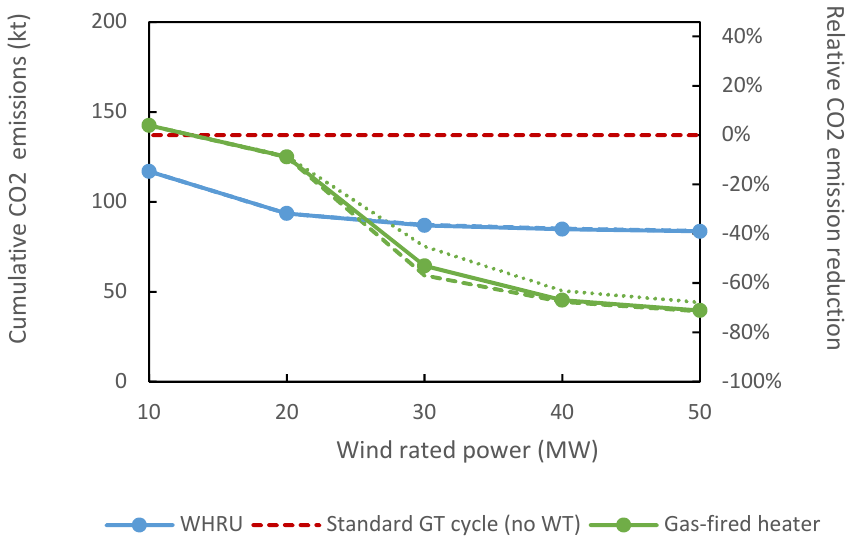
Figure 7. Absolute and relative CO 2 emissions for the different options analysed: reference case (full line), without a fuel cell stack (dotted line) and with the fuel cell performance increased by 50% (dashed line).